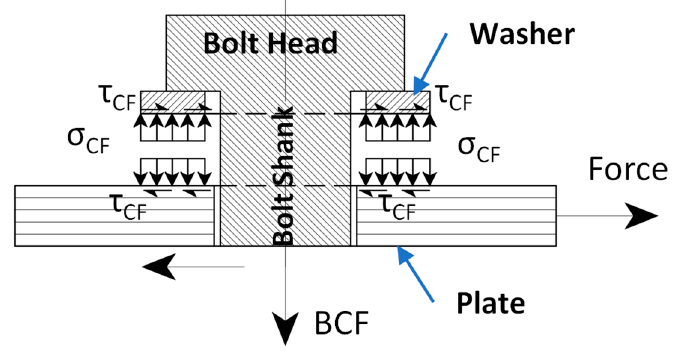
Figure 7. Friction type connection load transfer.